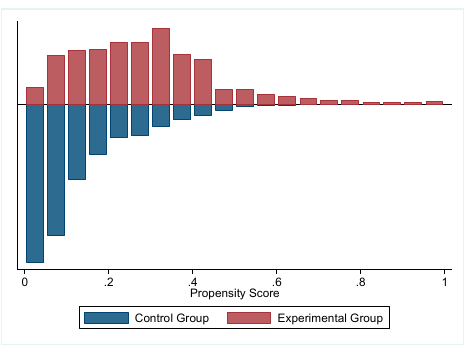
Figure 2. Distribution of sample propensity score matching.